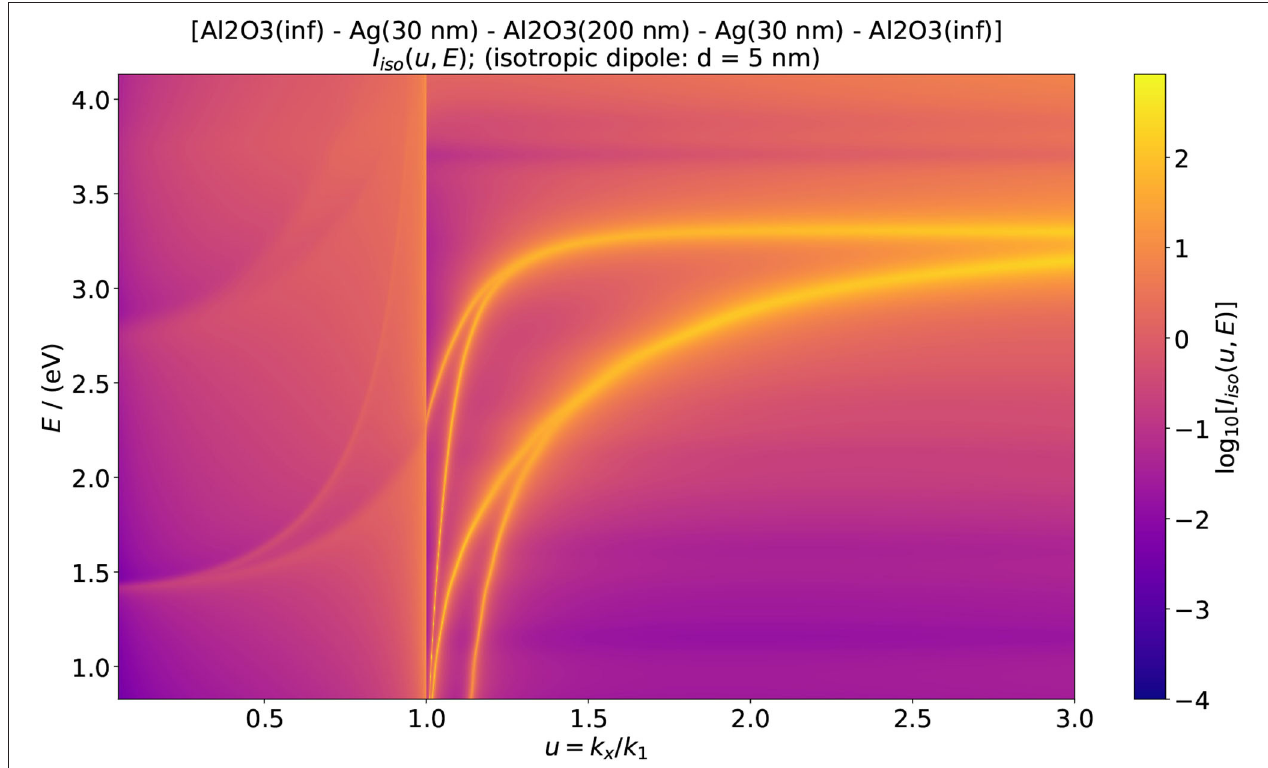
FIGURE 5 | Dispersion relation of the SPP modes supported in a pair of silver films separated by a dielectric layer of aluminum oxide. The materials and geometrical parameters are the same of the Figure 4 . The bright regions correspond to the highest density of power loss of an isotropic dipole located at 5 nm away the first silver surface. The less pronounced curves for effective index k x / k 0 < 1.0, correspond to TM and TE cavity